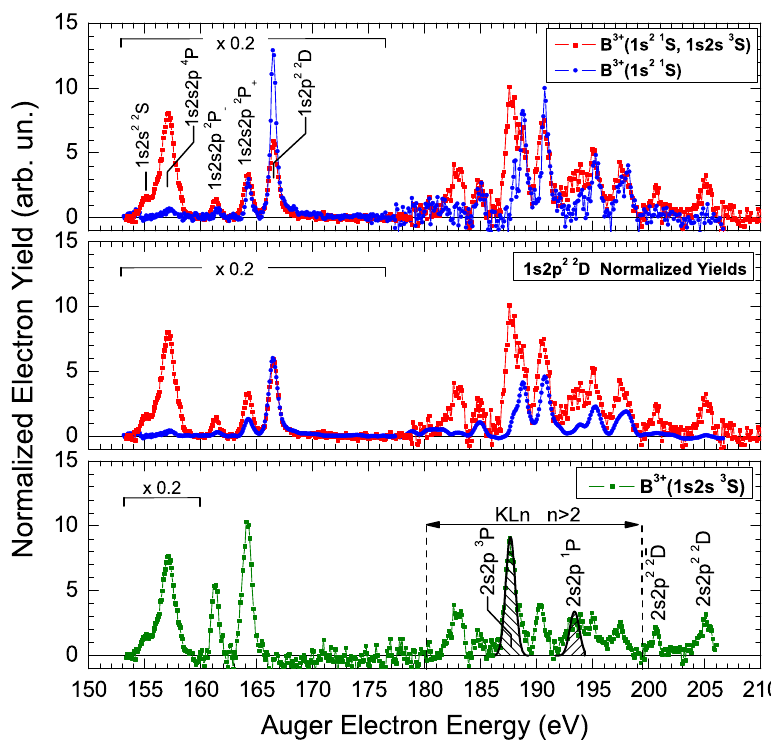
Figure 3. ( Top ) Li-like Auger spectra obtained in collisions of 4 MeV B 3 + with H 2 targets. The red squares correspond to the mixed-state (1 s 2 1 S ,1 s 2 s 3 S ) beam, while the blue dots to the almost pure ground state 1 s 2 1 S , as evident by the very small contribution of the 4 P peak. The high fraction spectrum was obtained with FPS, while the low fraction with GTS. ( Middle ) Same as in the top graph, but here the ground state spectrum was convoluted with the slightly larger energy resolution of the mixed-state spectrum and then normalized to the 1 s 2 p 2 2 D line. ( Bottom ) Li-like Auger spectrum corresponding just to the 1 s 2 s 3 S metastable state. The spectrum resulted from the subtraction of the two normalized spectra of the middle